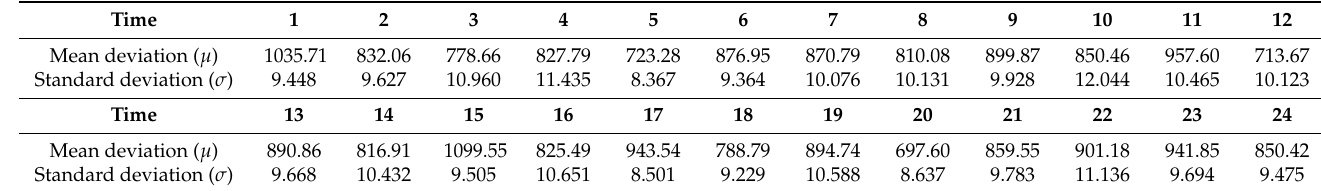
Table 10. Typical values for µ and σ (test system 2) [45].